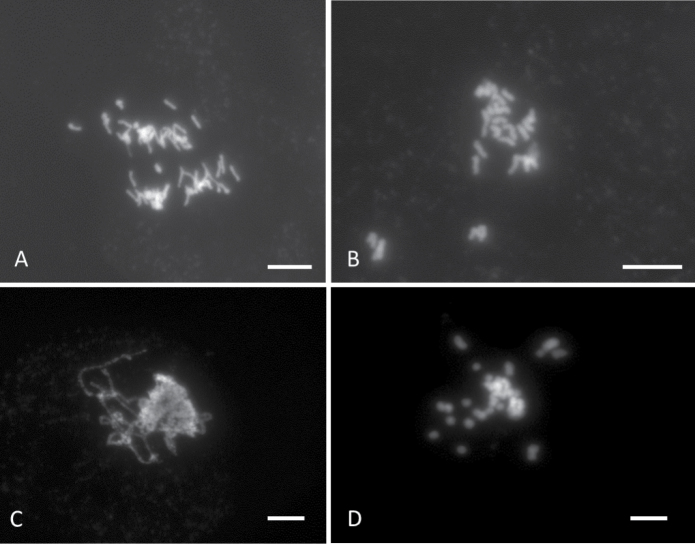
Mitotic and meiotic chromosomes of P.patens after DAPI staining. Anaphase (A), 1n ((B) protonema, n=27) and 2n ((D) sporophyte, 2n=54) metaphases and pachytene (C) stages. Scale bar: 5 µm.